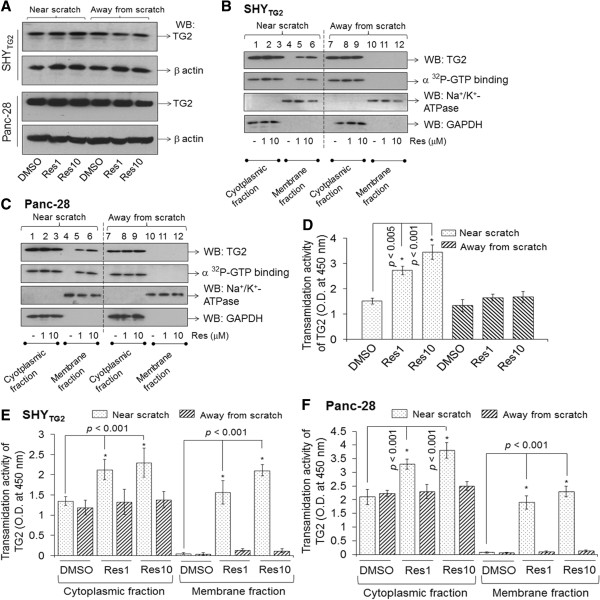
Cellular distribution and enzymatic activity of TG2 in response to resveratrol. (A) Representative Western blots showing TG2 protein level in total cell extracts prepared from SHYTG2 and Panc-28 cells. After 48 h treatment in scratch assays, cells near the scratch and away from the scratch were collected separately, and total protein extracts were prepared. Equal amount of proteins were separated on SDS-polyacrylamide gels and Western blots for TG2 were performed. Blots were reprobed with β-actin to indicate loading. (B and C) GTP-binding and Western blots for TG2 in cytoplasmic and membrane protein fractions prepared from SHYTG2(B) and Panc-28 cells (C). GTP-binding activity of TG2 was performed by UV-irradiating equal amount of proteins (5 μg) in the presence of [α32P]-GTP. UV-irradiated samples were separated by SDS-PAGE, transferred to PVDF membrane and exposed to x-ray films. Similar blots were probed with anti-TG2 antibody for Western blotting. Antibodies against Na+/K+-ATPase and glyceraldehyde 3-phosphate dehydrogenase (GAPDH) were used as plasma membrane and cytoplasmic protein markers, respectively. (D, E and F) Bar diagrams representing transamidation activity of TG2 in SHYTG2 and Panc-28 cells. After treatments in scratch assays, total cell lysate of SHYTG2(D), and cytoplasmic and membrane protein fractions of SHYTG2 and Panc-28 cells (E and F) prepared from cells present near and away from scratch, and transamidation activity was measured by colorimetric assay at 450 nm. Experiments were repeated at least three times. *p < 0.05.